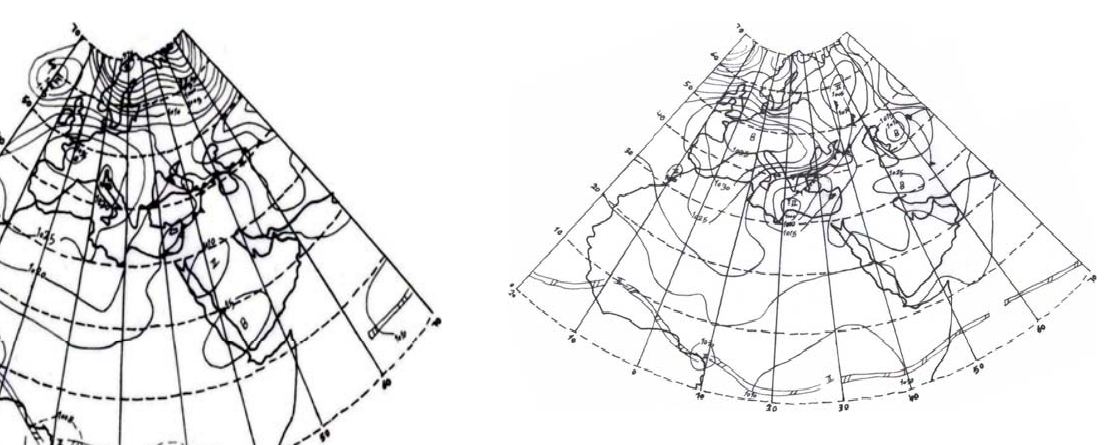
Fig. 6 The pattern of the surface isobars (AAXX) 48 hours before the rainfall (Type II: 6 January 1978)